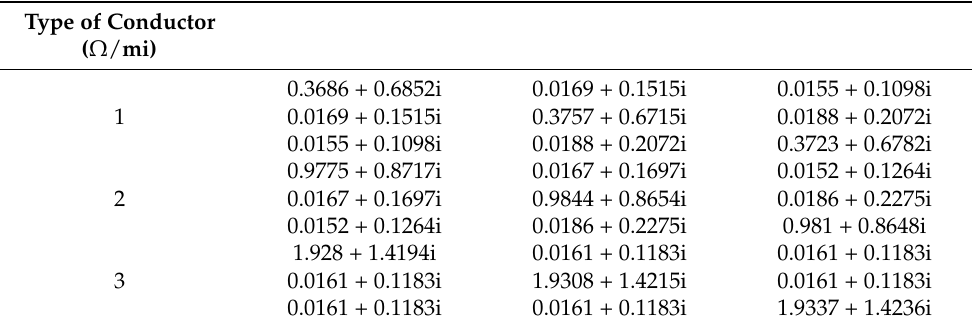
Table A4. Impedance matrix for the type of conductor in the 25-node test system.